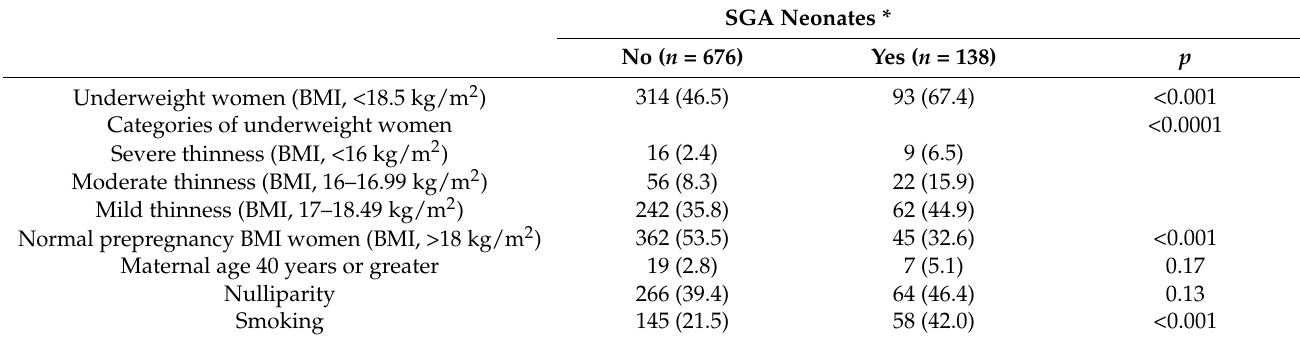
Table 4. Univariate analysis of SGA neonates among underweight and normal prepregnancy BMI women. SGA Neonates